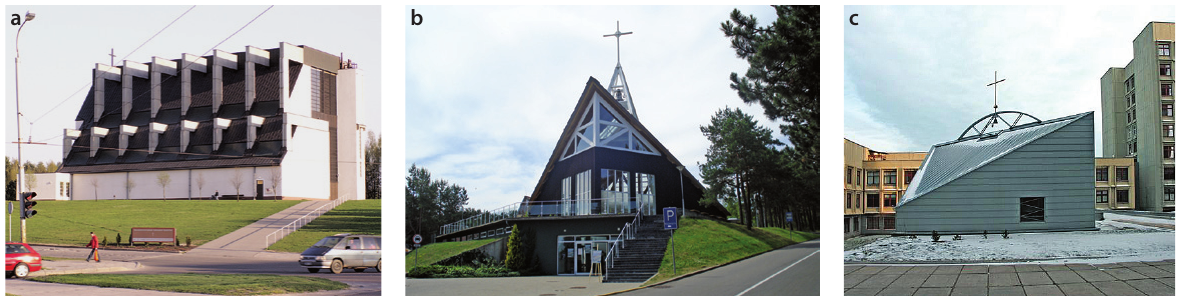
Fig. 7. Churches of Integral model: a – Church of Blessed Jurgis Matulaitis in Vilnius, Viršuliškės (archit.: G. Baravykas,